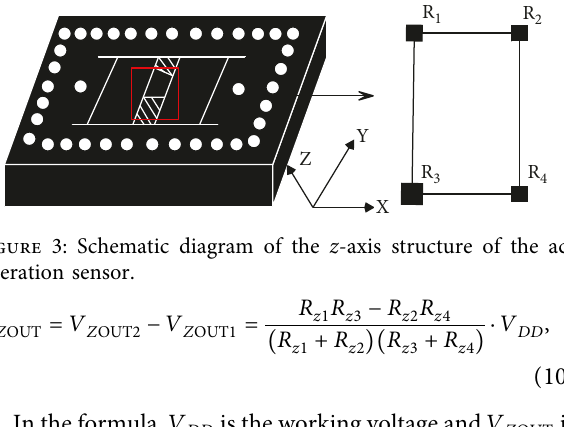
0kPa; (b) P 0kPa. (cid:31) (cid:31)